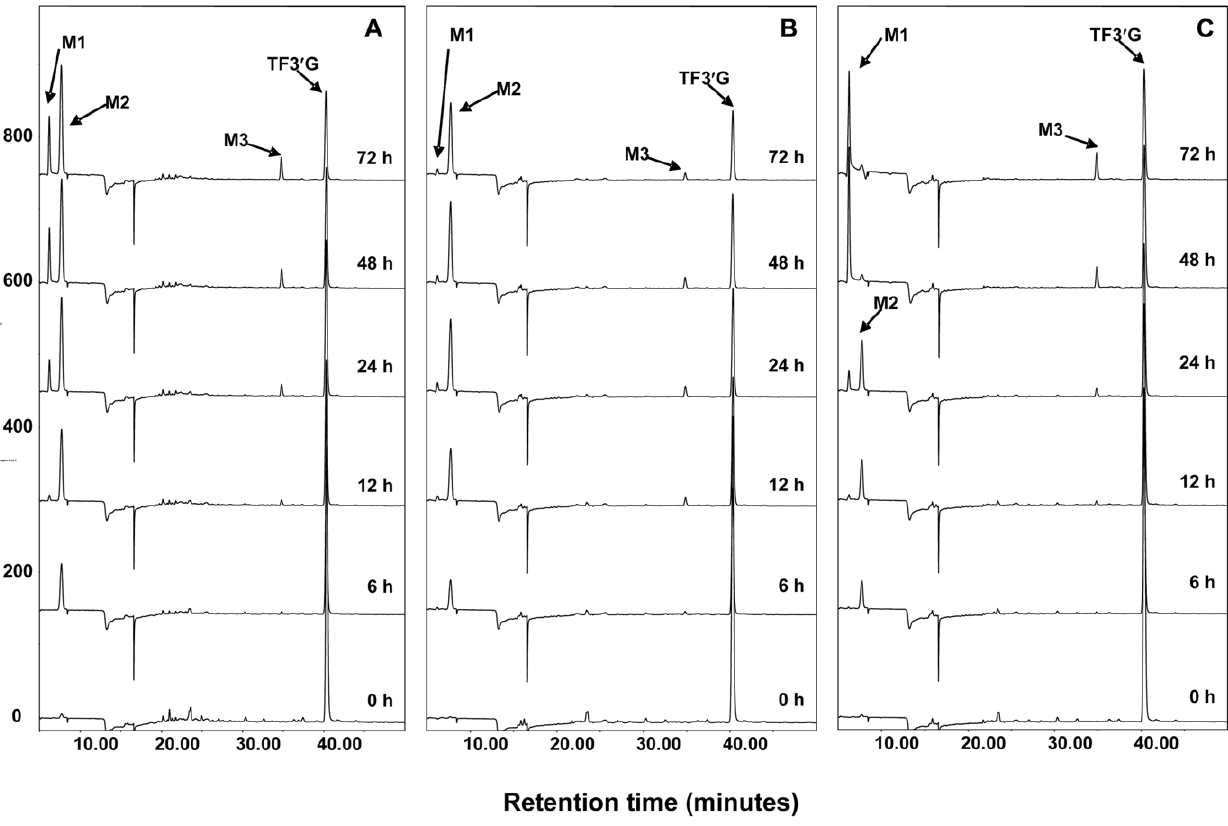
Figure 6. HPLC-ECD chromatograms of microbial metabolites of TF3 9 G after incubation with human fecal bacteria (A–C). A, B and C represent the three human volunteers, respectively. TF3 9 G: theaflavin 3 9 -gallate.